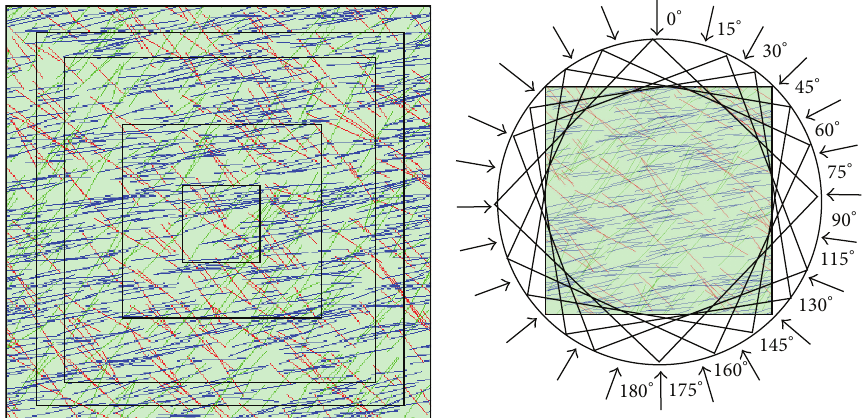
Figure 10: Generated fracture network by Monte Carlo method (side length of internal squares is 1m, 4 m, 7m, 8 m, and 9m,